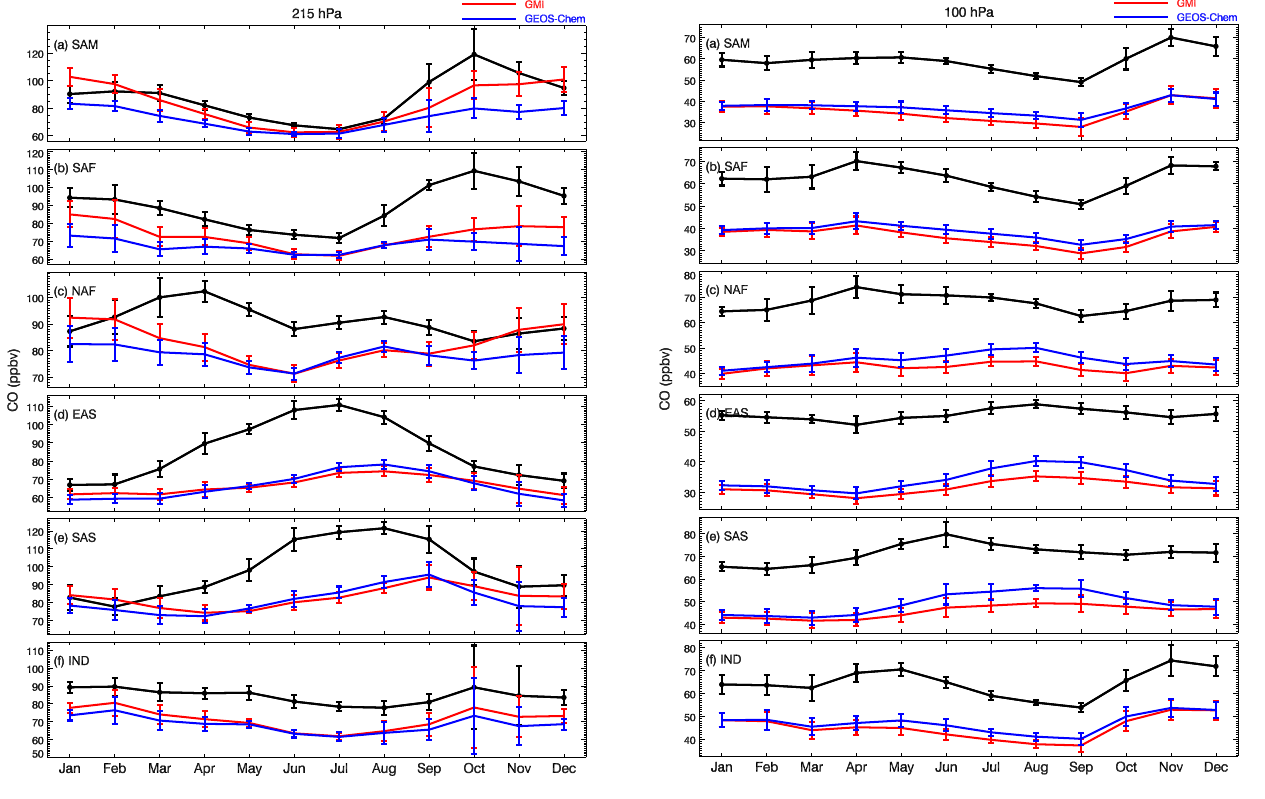
Figure 12. Climatological (8-year) monthly mean of CO mixing ra- tio at 215hPa from MLS V4 data (black line), GMI model simula- tion with MLS AKs applied (red line) and GEOS-Chem model sim- ulation with MLS AKs applied (blue line) over the selected six re- gions: (a) South America, (b) southern Africa, (c) northern Africa, (d) East Asia, (e) South Asia and (f) Indonesia. The error bars in- dicate ± 1 interannual standard deviation of the monthly mean CO from MLS observation and model simulations.